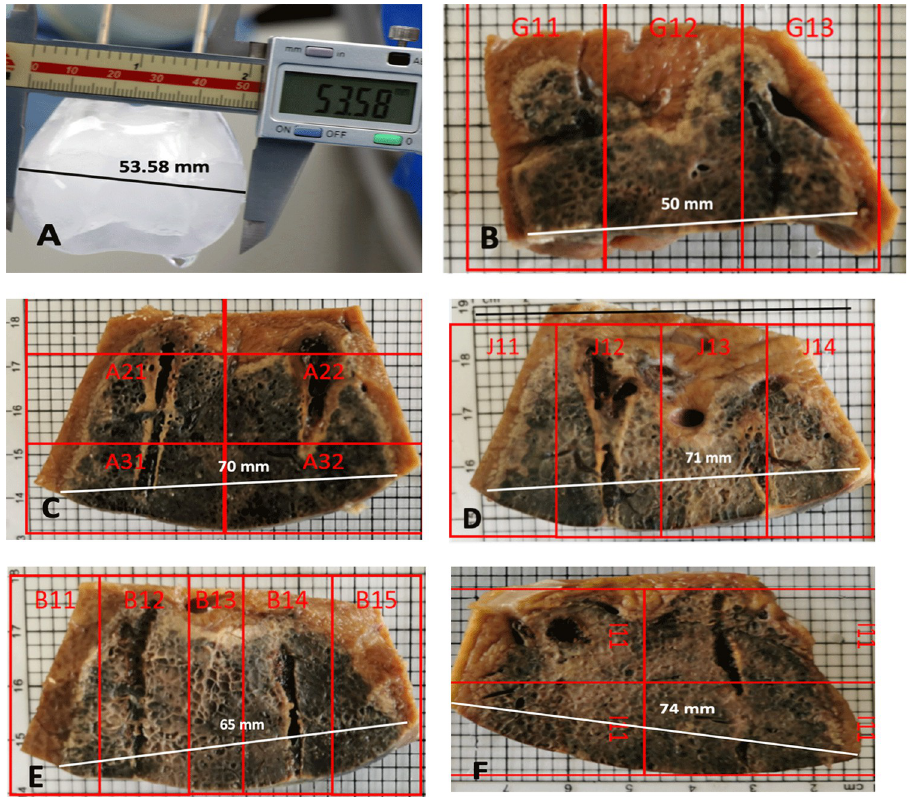
Fig 4. Macroscopic cross sections of liver treated with cryoablation and cryoelectrolysis following fixation.